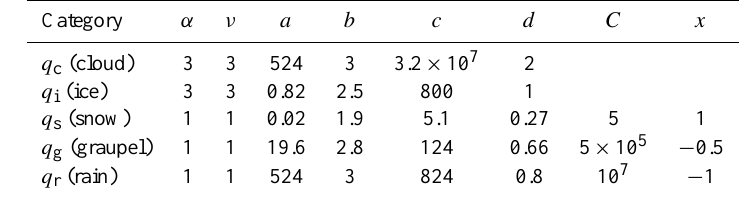
Table 1. Parameters of the Meso-NH microphysical scheme described by Eqs. (1)–(5) (given in MKS units).